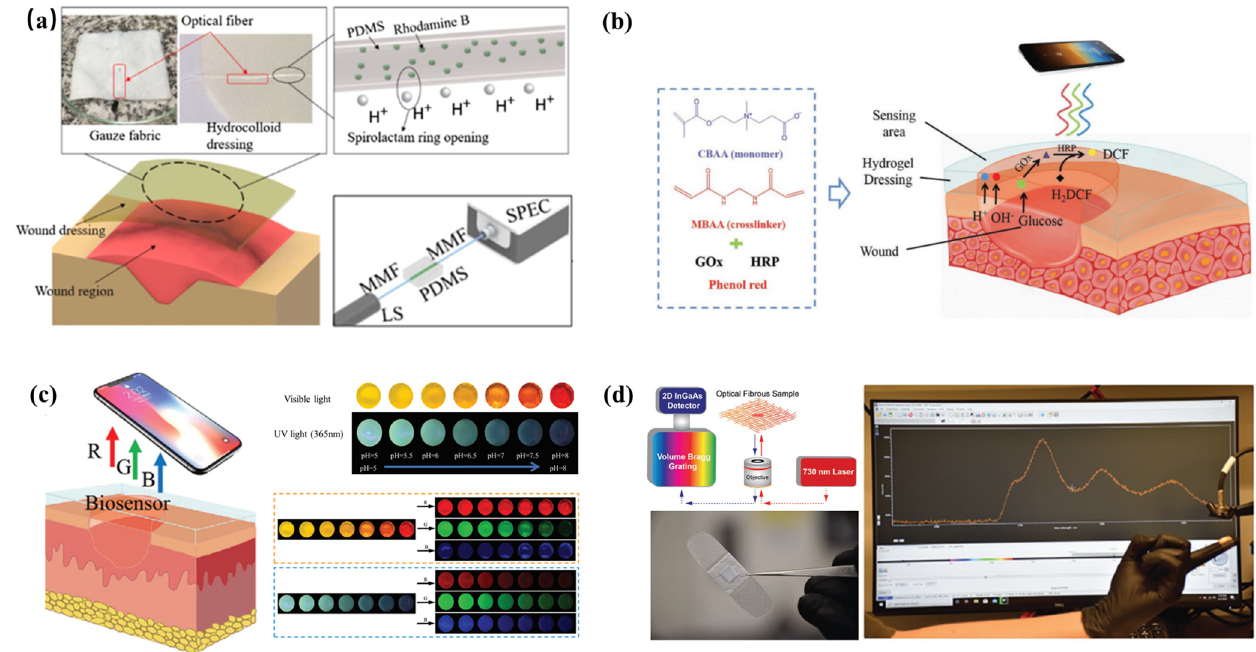
Figure 6. Portable wound detection devices using optical detection methods. ( a ) Schematic of quantitative detection of pH and pressure using the spectrometer USB2000+ [151]. Copyright (2021) Chinese Laser Press. ( b ) A photographic method to establish functional relations between glucose/pH and RGB intensity using a smartphone [152]. Copyright (2019) John Wiley and Sons. ( c ) A remote approach of dynamic wound status evaluation with the RGB analysis of the images collected by smartphones [154]. Copyright (2021) John Wiley and Sons. ( d ) A wearable wound bandage attached the microfibrous platform for in situ monitoring of peroxide [157]. Copyright (2021) John Wiley and Sons.